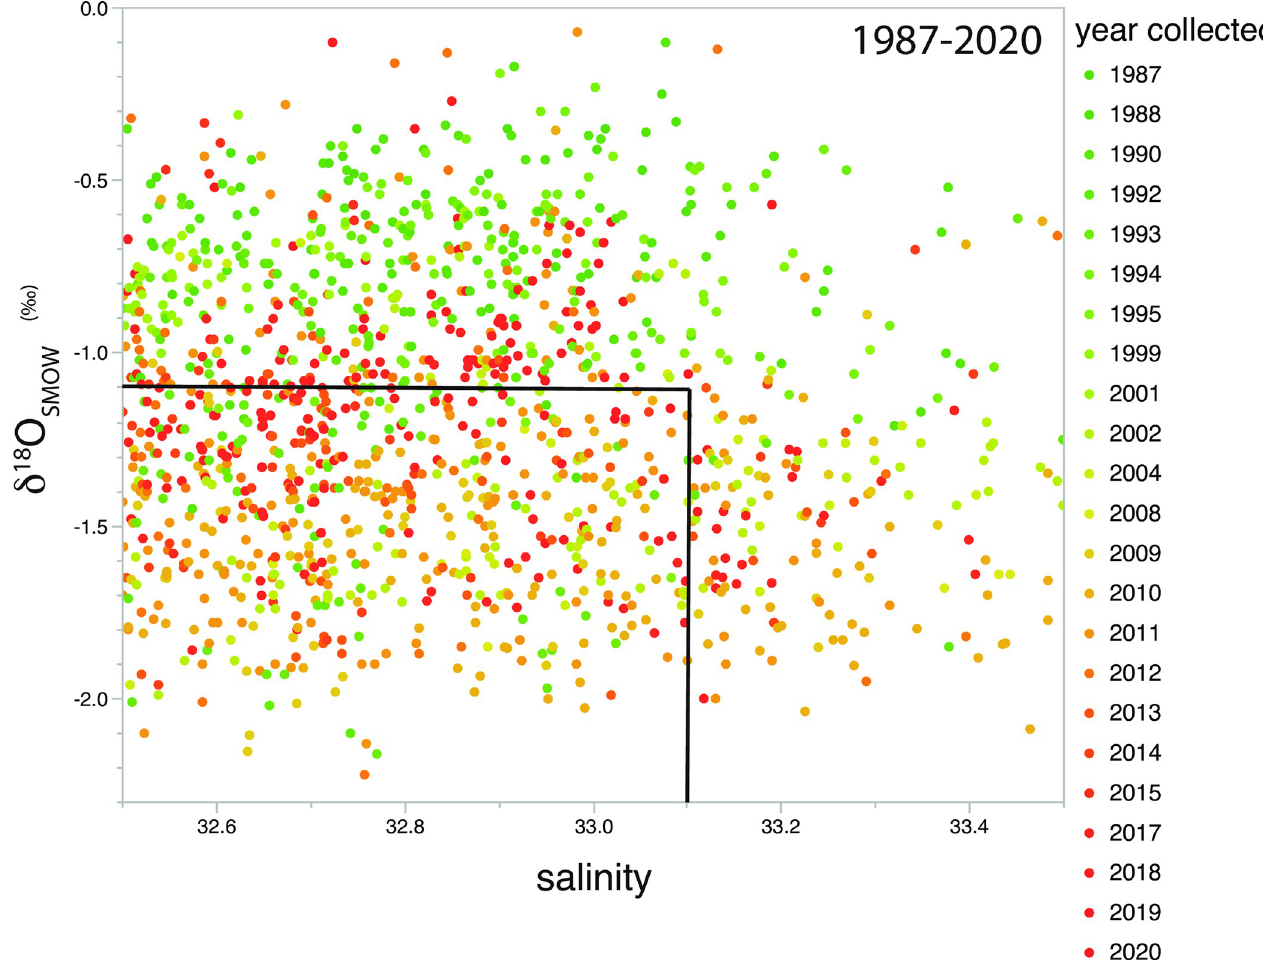
Fig 3. Distribution of δ 18 O values relative to salinity for 1405 samples collected between 1987 and 2020 in the north Bering and Chukchi seas, and Arctic Ocean. The salinity (33.1) and δ 18 O value (-1.1‰) associated with the upper Arctic Ocean halocline are denoted by the two black lines. Color coding of δ 18 O values by years range from greenish for early years (1987–2000), yellowish for middle years (2001–2011), and reddish for recent years (2012–2020) of the time